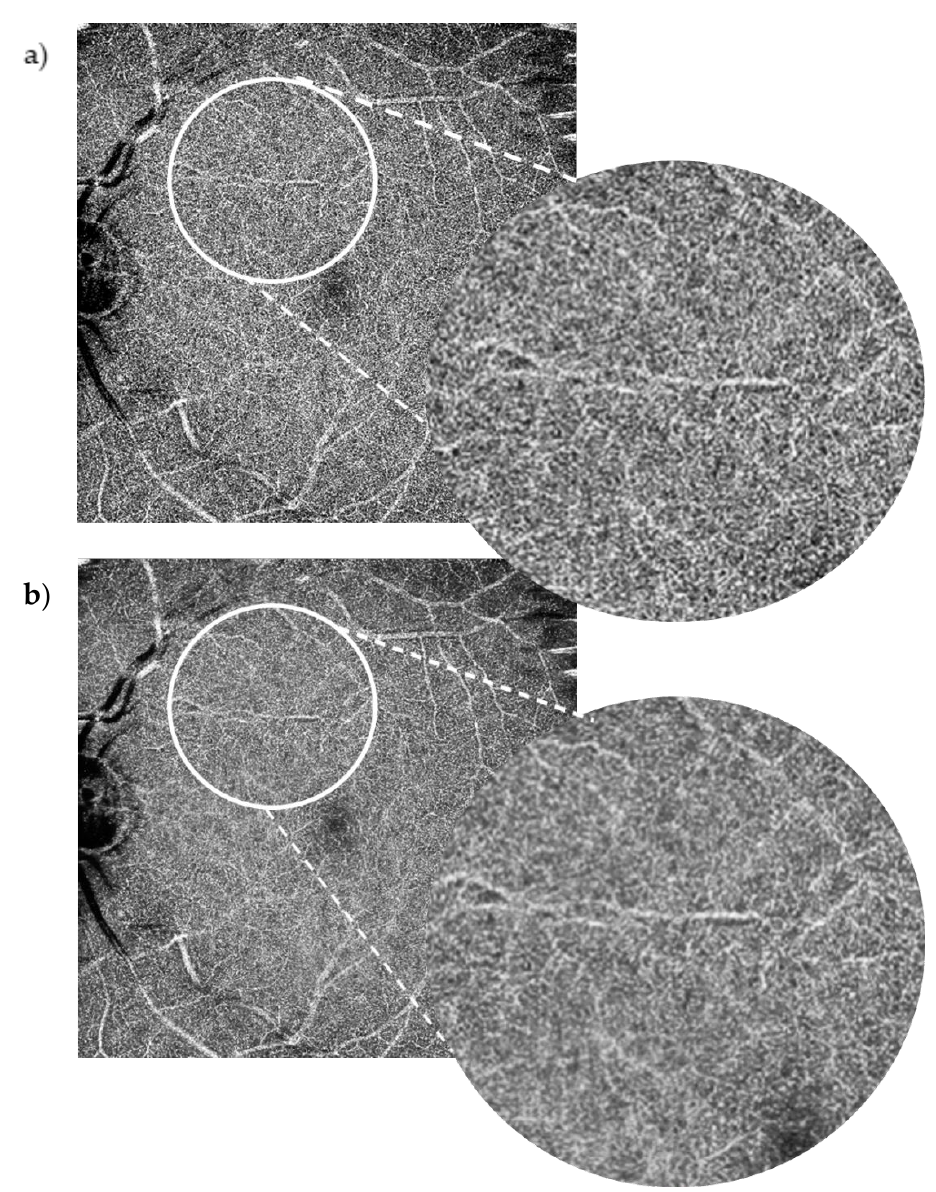
Figure 2. 10 × 10 mm OCT-A scan of the deep capillary plexus. Baseline image ( a ) vs. denoised image ( b ). The positive impact of the denoise software on the Superficial Capillary Plexus (SCP) did not apply to the same extent to the Deep Capillary Plexus (DCP). Although the more clinically standard smaller field DCP scans were of higher quality, the widefield 10 × 10 mm images for this study showed shadowing from the SCP and relative loss of clarity.